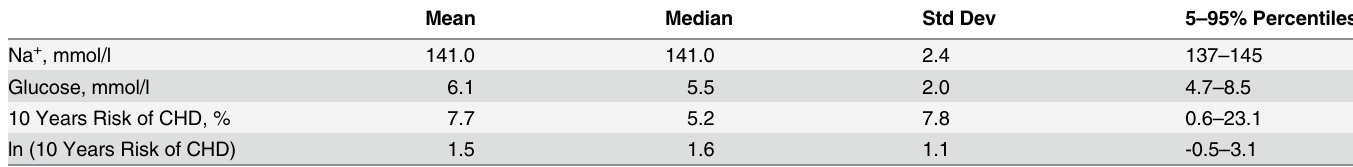
Table 2. Basic descriptive statistics for the variables used in analysis of the association between sodium and 10 Years Risk of CHD in the ARIC Study (N =